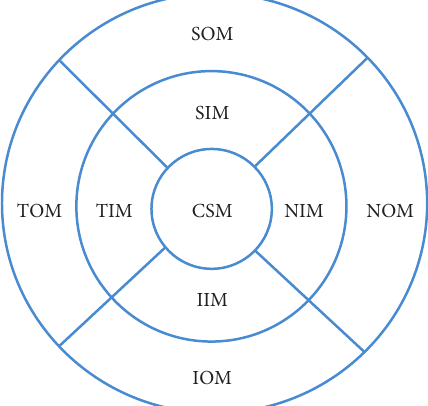
Figure 1: Measurement illustration of macular choroidal thickness at nine locations (reproduced from Li et al. [12]). CSM: central subfield macula; NIM: nasal inner macula; SIM: superior inner macula; IIM: inferior inner macula; TIM: temporal inner macula; NOM: nasal outer macula; SOM: superior outer macula; IOM: inferior outer macula; TOM: temporal outer